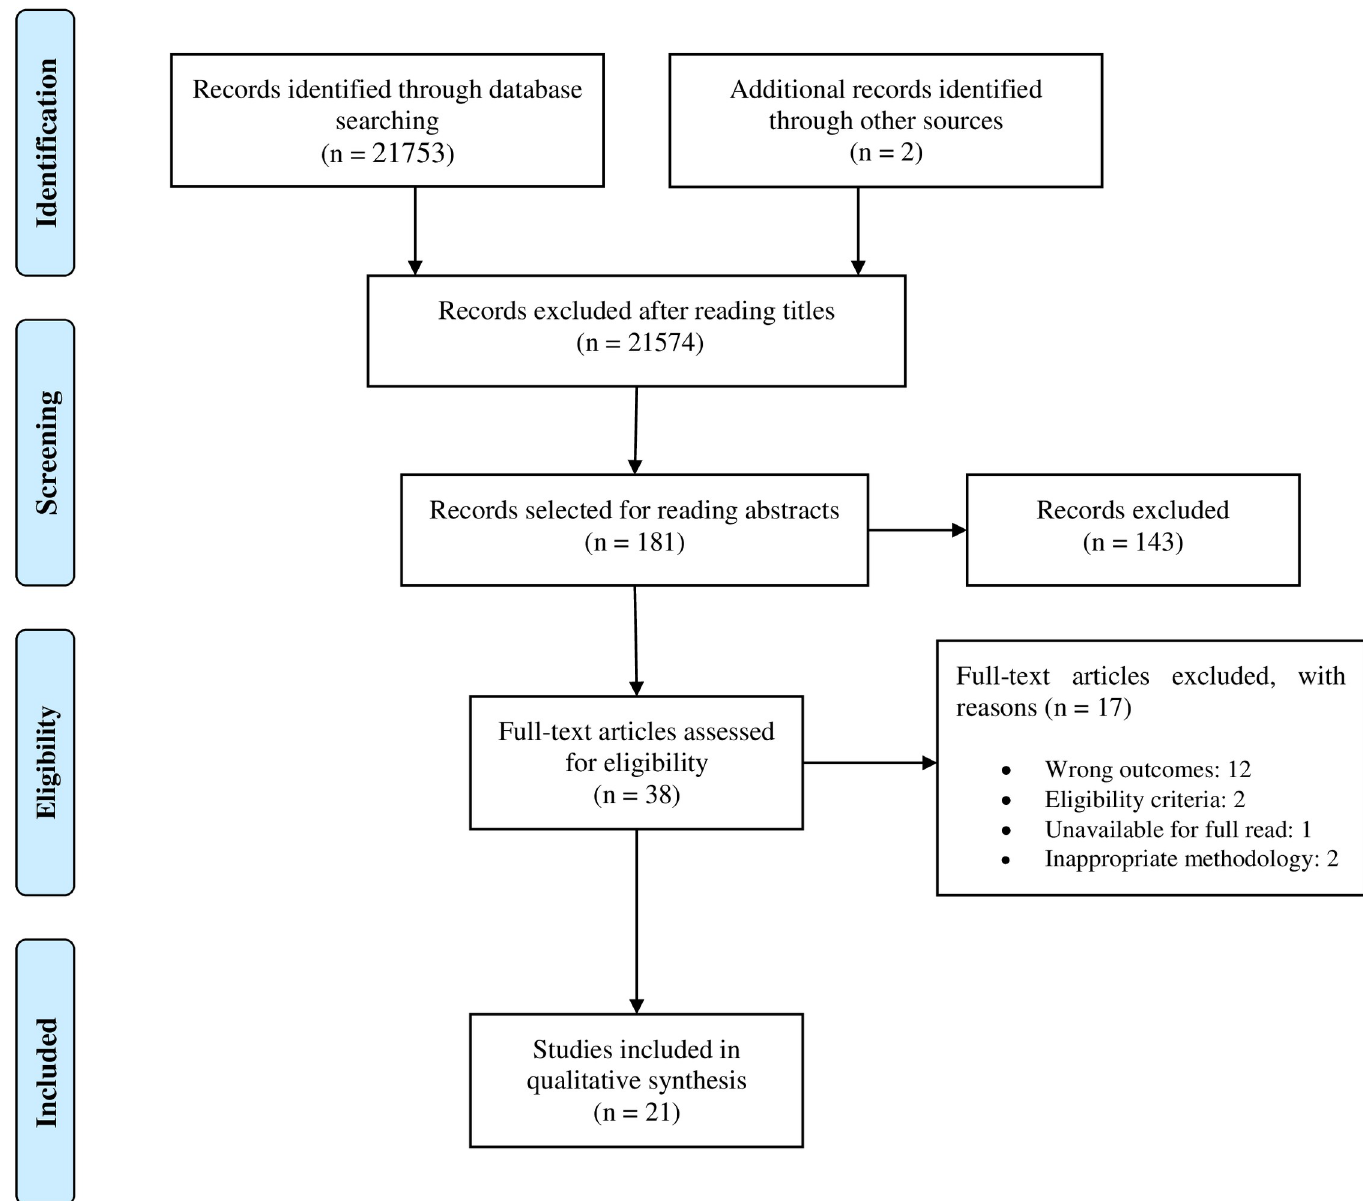
Fig 1. PRISMA flow diagram for the systematic